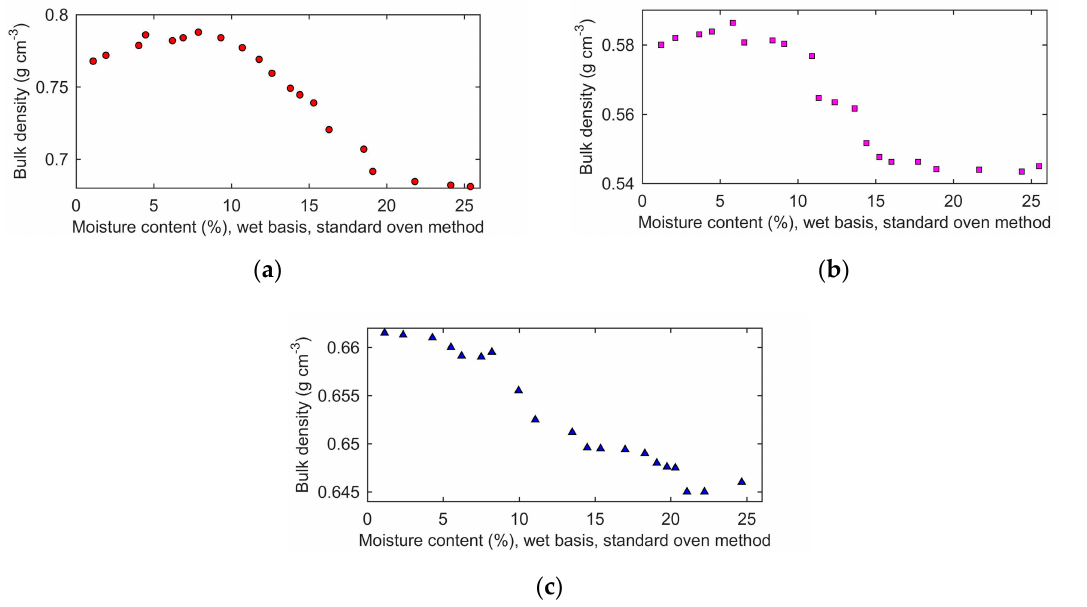
Figure 10. Bulk density of the prepared grain samples dependent of moisture content: ( a ), wheat; ( b ), rough rice; ( c ), barley.